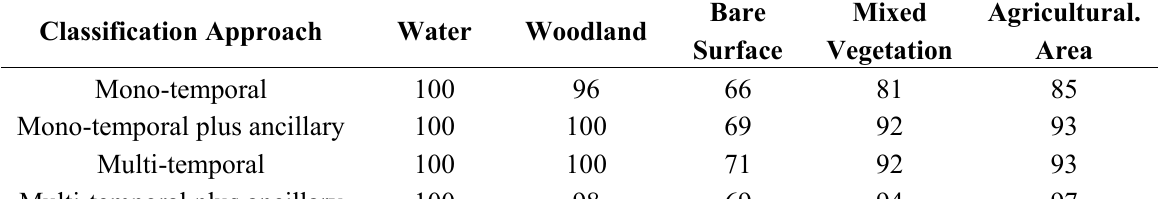
Table 14. LULC producer’s accuracy (%) per image combination in 2011.